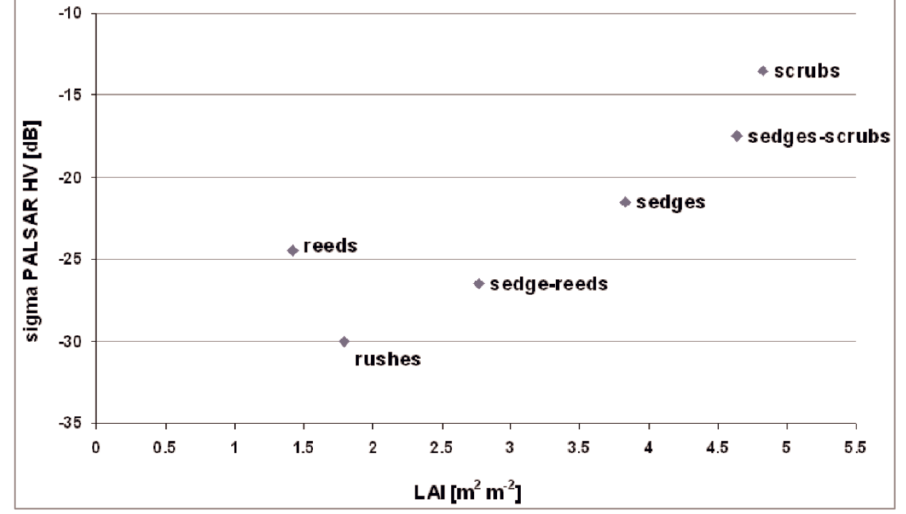
Figure 12. Relationship between mean σ° (sigma) and mean LAI for wetland